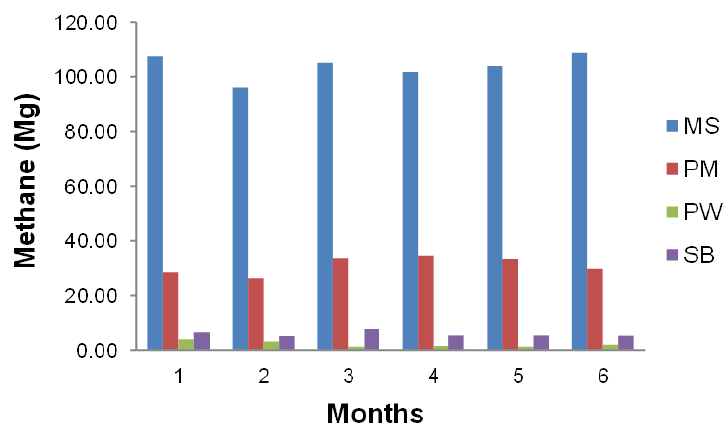
Figure 2. The mass of methane produced from the substrates in each month of the experiment.